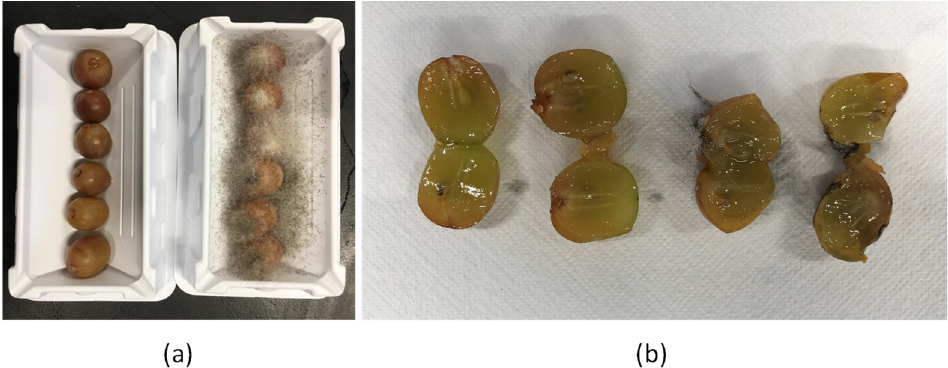
Figure 1. Table grapes artificially contaminated with R. oryzae ITEM 18876 (10 6 spores/mL) and incubated under citral exposure (0.0125 μ L/cm 3 ) for seven days at 25 °C. ( a ) Comparison between the inoculated treated ( left ) and not-treated ( right ) grape berries. ( b ) A section of the grape berries showing structure changes between the inoculated treated ( left ) and not-treated ( right ) samples.